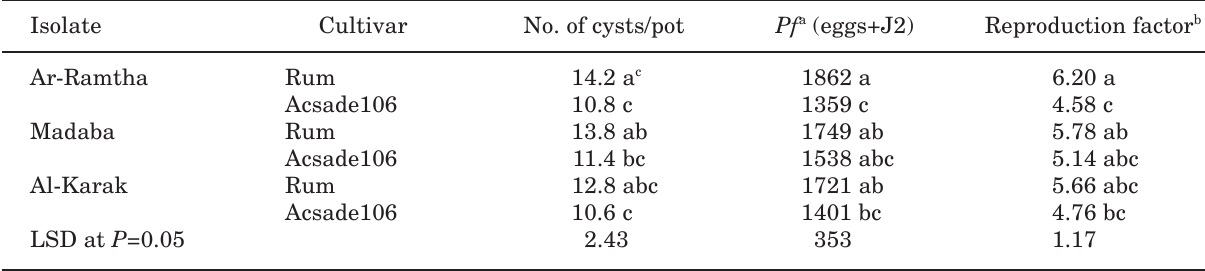
Table 5. Reproduction of three geographical isolates of Heterodera latipons on barley cv. Rum and Acsade 106. Isolate Cultivar No. of cysts/pot Pf a (eggs+J2)